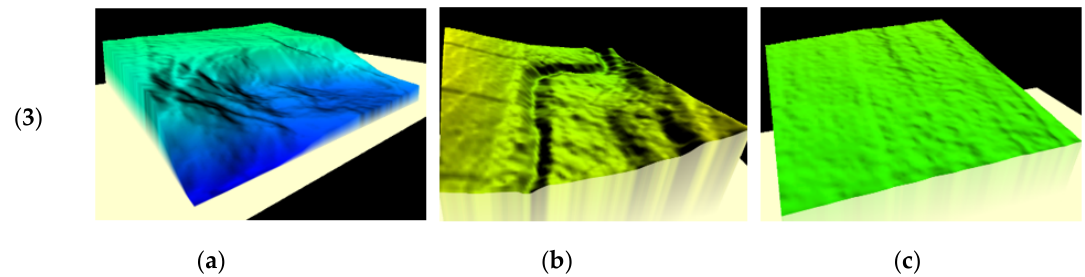
Figure 2. Three kinds of terrain with their 3D visualization and marked microrelief objects on them: ( a ) convex object (bluff); ( b ) concave object (stream); ( c ) flat terrain; ( 1 ) orthophotomap; ( 2 ) digital elevation model (DEM) visualization; ( 3 ) 3D DEM visualization.